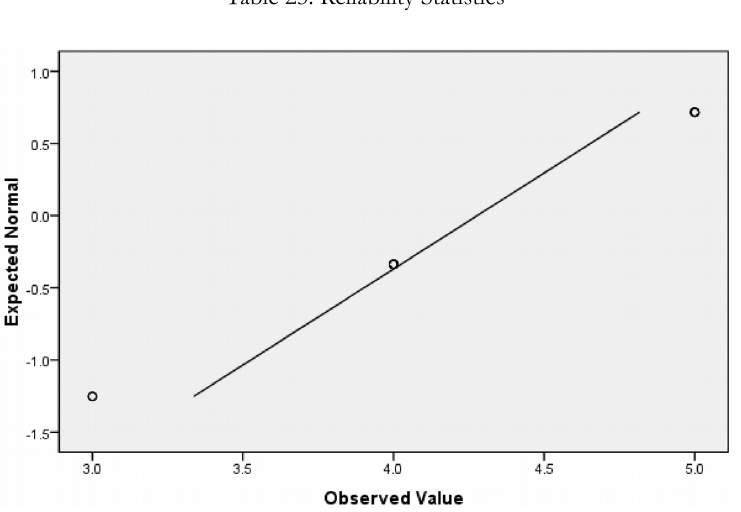
Figure 2. Normal Q-Q plot of increased usage of ICTs tool in